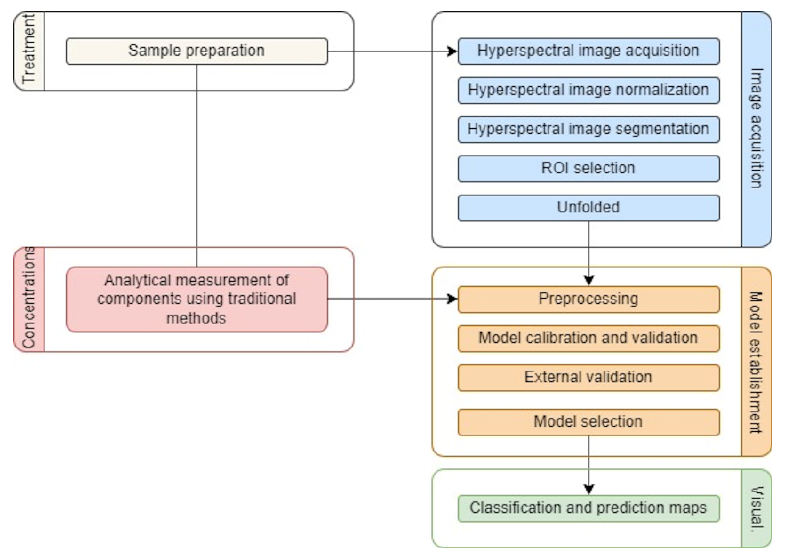
Figure 3. General flowchart of the image process carried out. Adapted from Ma et al. [38].